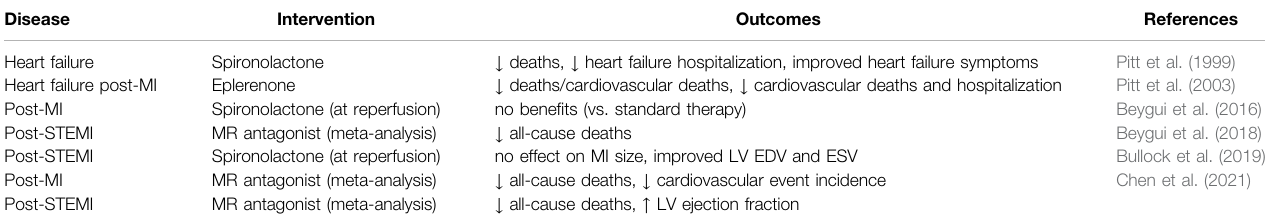
TABLE 1 | Summary of clinical trials assessing MR antagonist intervention outcomes. Disease